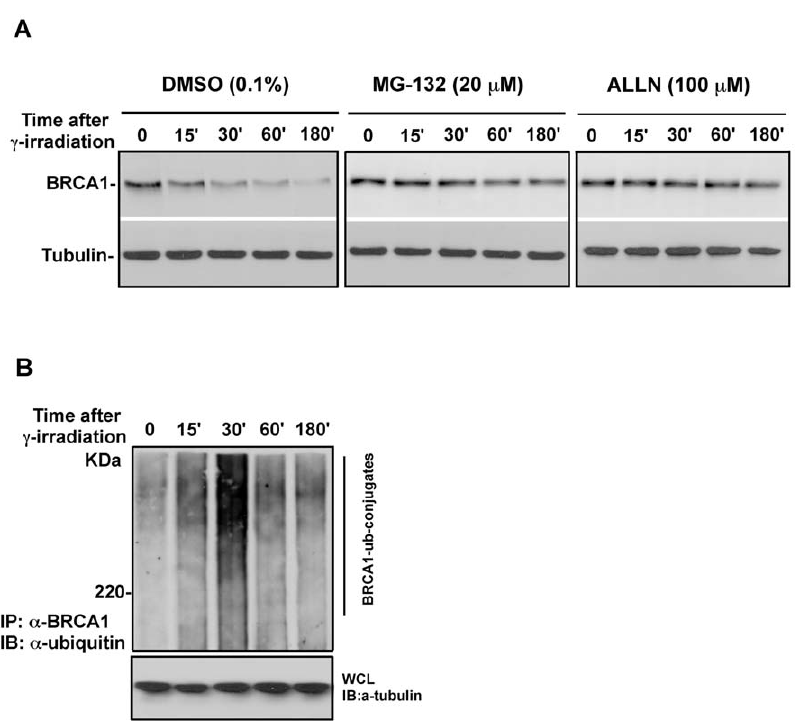
Figure 2. c irradiation-induced degradation of BRCA1 is mediated by the ubiquitin-proteasomal pathway. A . c irradiation-induced degradation of BRCA1 is blocked by proteasome inhibitor MG-132 or ALLN. HeLa S3 cells were preincubated with DMSO (vehicle control), MG-132 and ALLN for 20 minutes followed by exposure to c irradiation. Cells were collected at indicated time points. BRCA1 protein levels were detected by immunoblotting. BRCA1 mRNA was monitored using RT-PCR. B . BRCA1 is ubiquitylated prior to degradation following exposure to c irradiation. HeLa cells were harvested at different time points after exposure to c irradiation. Cell pellet was lysed with denature-lysis buffer. Ubiquitin-conjugated BRCA1 was pulled down by antibody against BRCA1 and further detected by immunoblotting using antibody against